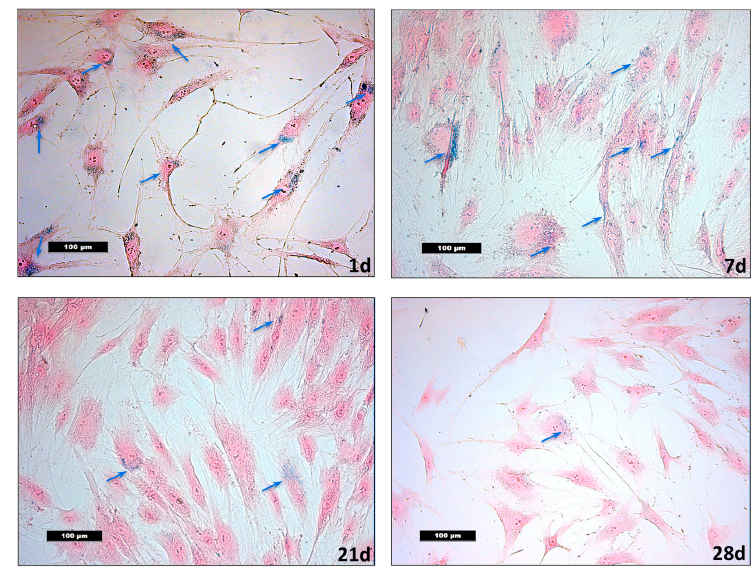
Figure 3. Intracellular very small iron oxide nanoparticles (VSOPs) become visible with the help of the Prussian blue staining. During passage, the percentage of labelled human adipose tissue derived stromal cells (hASCs) seems to decrease compared to unlabelled cells. The histologic images of hASCs 24 h, 7 days, 21 days and 28 days after labelling are shown. Intracellular blue particles are marked by blue arrows. The population doubling time was 5.4 days. Magnification ×200 in all figures; the scale bars represent 100 µm.